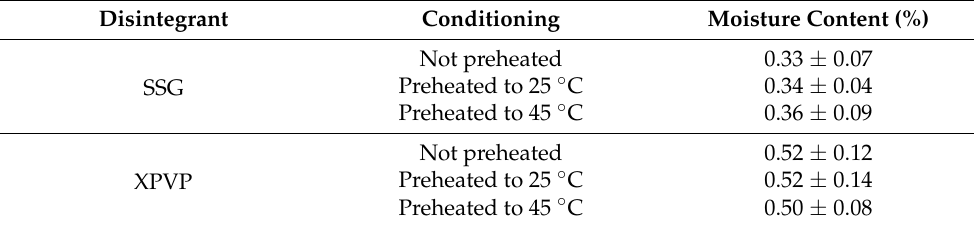
Table 2. Moisture content of